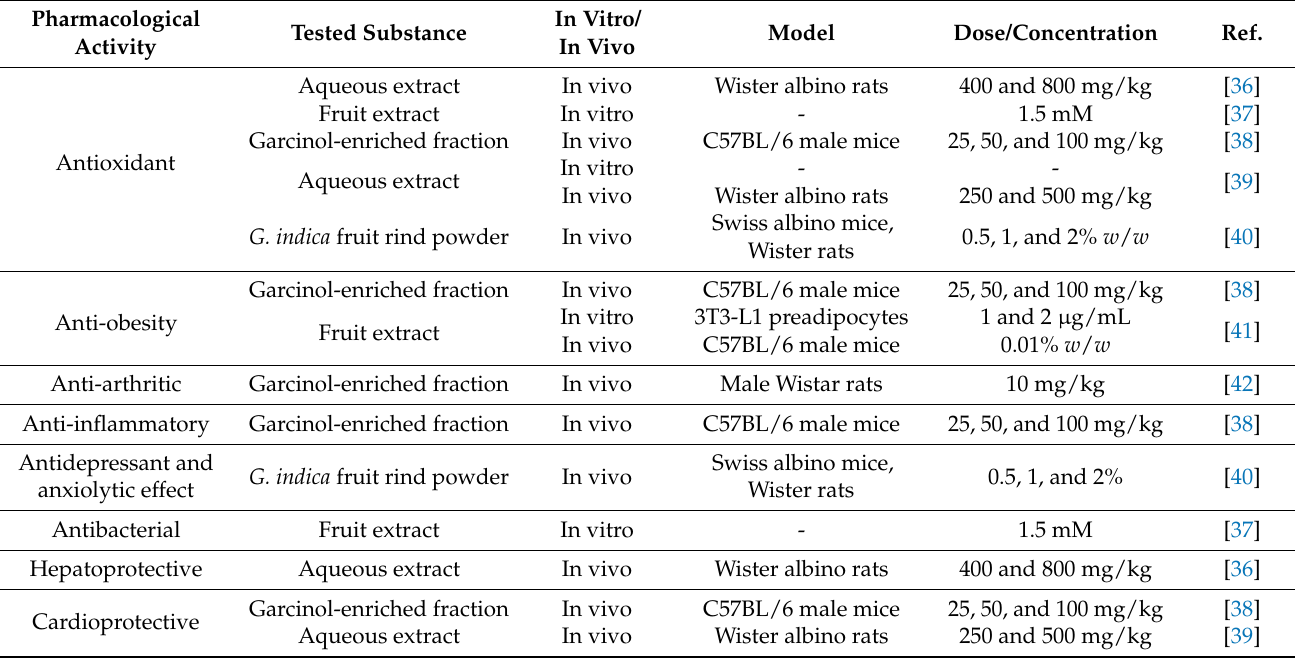
Table 1. Summary of pharmacological studies for Garcinia indica